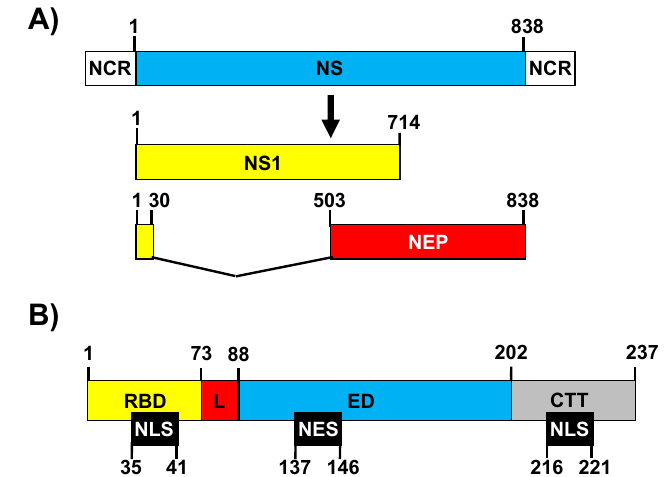
Figure 1. A schematic representation of an influenza A virus (IAV) non-structural (NS) segment, viral transcripts, and NS1 domains. ( A ) An IAV NS RNA segment is indicated by a blue box and non-coding regions (NCR) are indicated with white boxes. IAV NS1 and nuclear export protein (NEP) transcripts are indicated with yellow and red boxes, respectively. IAV NS1 and NEP open reading frames (ORFs) shared the first 30 nucleotides in the N-terminus. The numbers on the top of the bars represent the ORF length and nucleotide splice positions. ( B ) The NS1 protein is divided into four distinct regions: The N-terminal RNA-binding domain (RBD; amino acids 1–73, yellow), the linker sequence (L; amino acids 74–88, red), the effector domain (ED; amino acids 89–202, blue), and the C-terminal tail (CTT; amino acids 203 to the end, gray). Note that both the L and the CTT can vary in length among different IAV strains, and, although a 237 amino-acids-length NS1 has been represented, the NS1 can be 219, 230, and 237 amino acids in length. Nuclear localization and export signals (NLS and NES, respectively) are indicated with black boxes at the bottom.